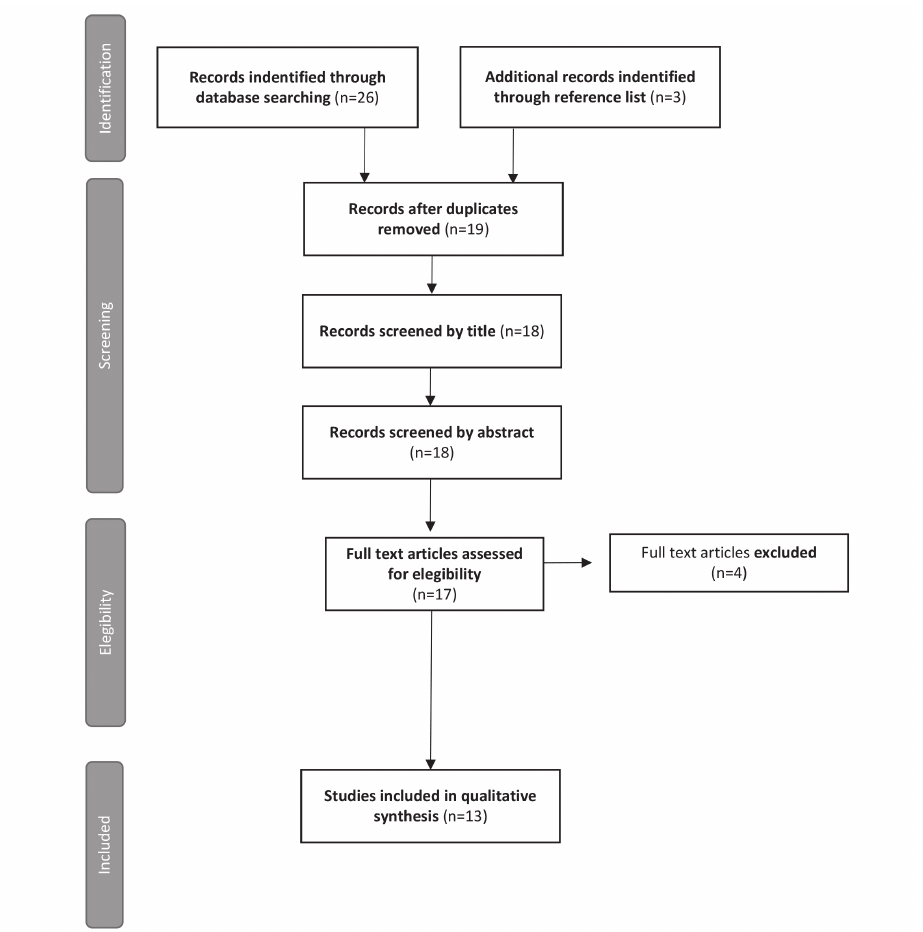
FIGURE 1. PRISMA flow diagram of search